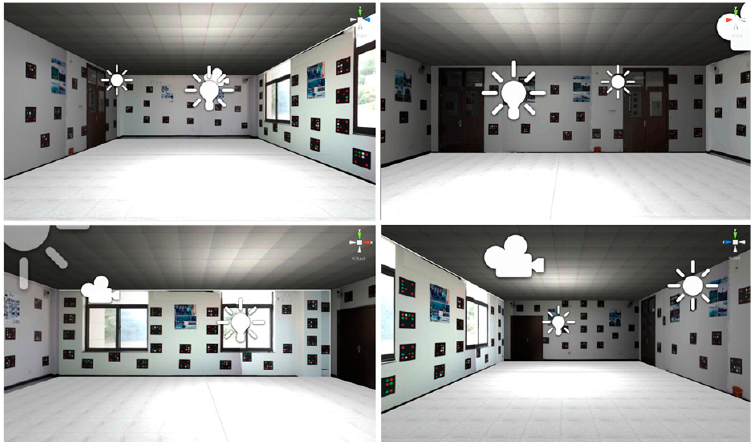
Figure 5. Three-dimensional texture visualization mode indoor scene.